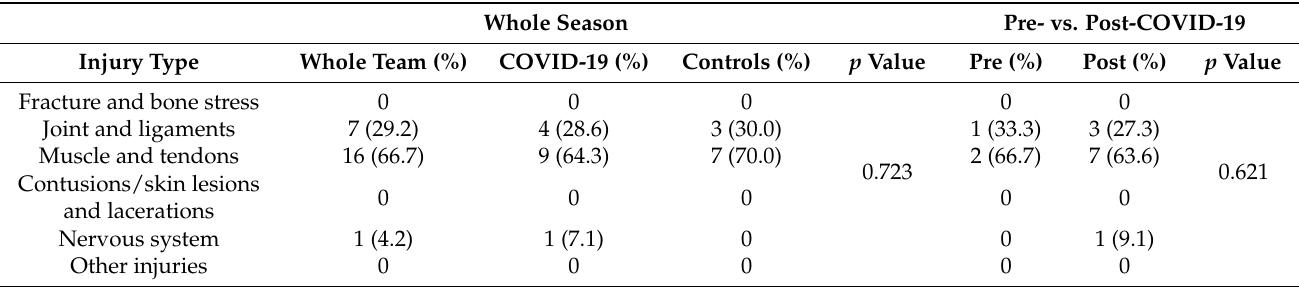
Table 5. Injury type in players diagnosed with COVID-19 and players who did not have COVID-19 during the 2020–2021